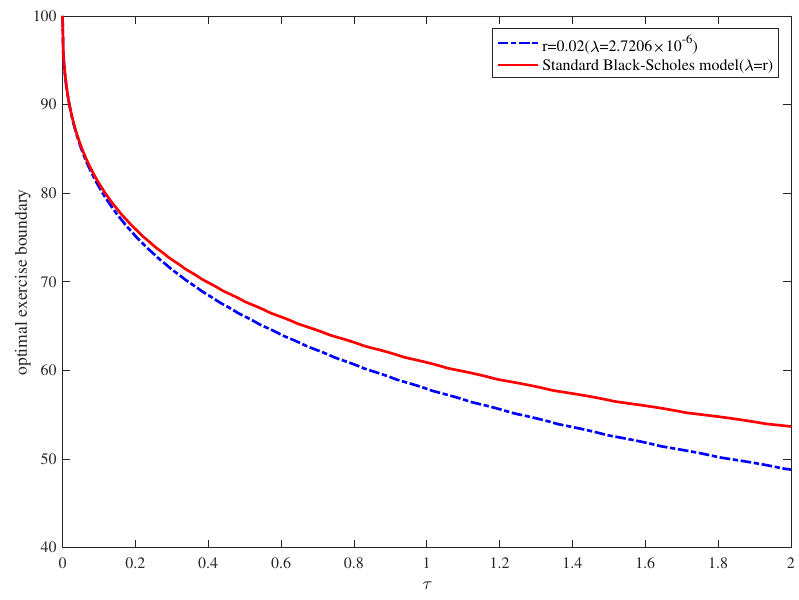
Figure 3. Optimal exercise boundary for r = 0.02 (and also λ = 2.7206 × 10 − 6 ). ( T = 2, σ = 0.3, K =